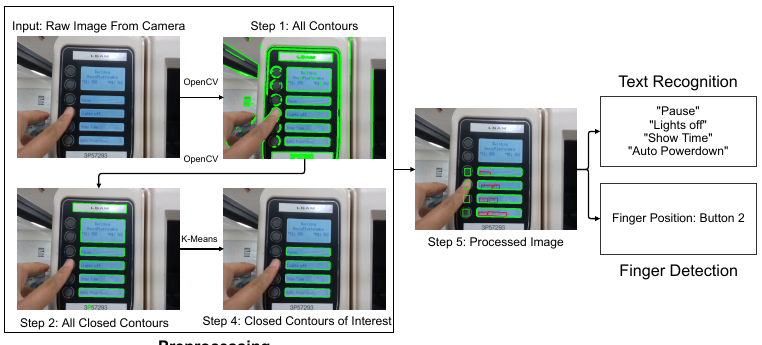
Figure 4. Workflow of the finger-text detection